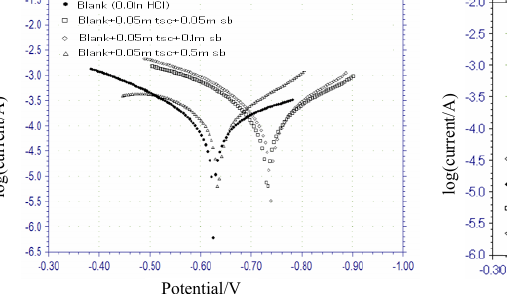
Figure 1. Tafel curves of mild steel in 0.01 N HCl in absence and presence of various concentration of citrate and benzoate inhibitors